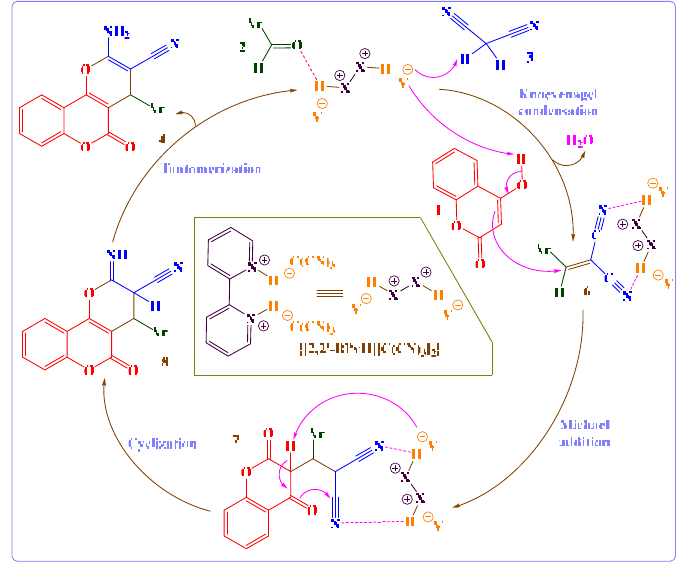
Scheme 2. Proposed mechanism for the synthesis of 3,4-dihydropyrano[ c ]chromenes using {[2,2'-BPyH][C(CN) 3 ] 2 }.